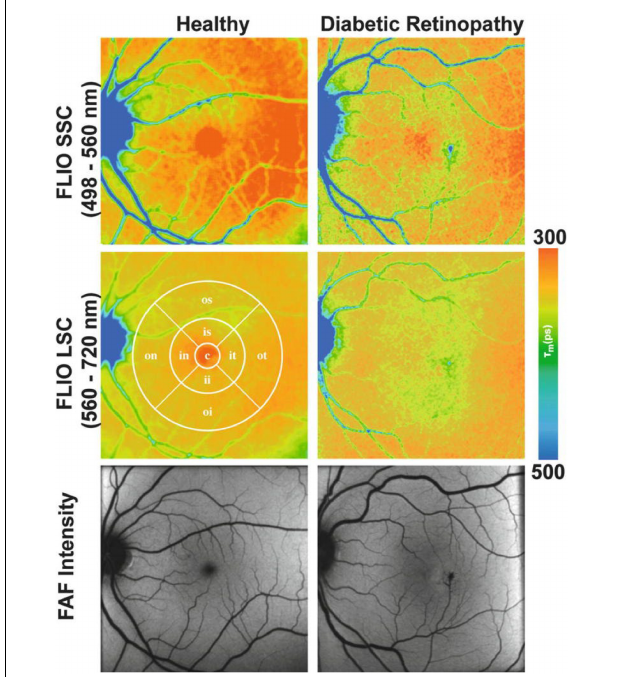
FIGURE 7 | Funds autofluorescence (FAF) lifetime images (FLIO) and FAF intensity images in diabetic retinopathy (DR). Mean funds autofluorescence (FAF) lifetime images (FLIO) from two spectral channels, as well as FAF intensity images from the retina of a healthy control (Left) and a diabetic retinopathy patient (Right) . The middle left panel comprises a standardized ETDRS grid. This figure was reprinted from Bernstein et al. (455) with